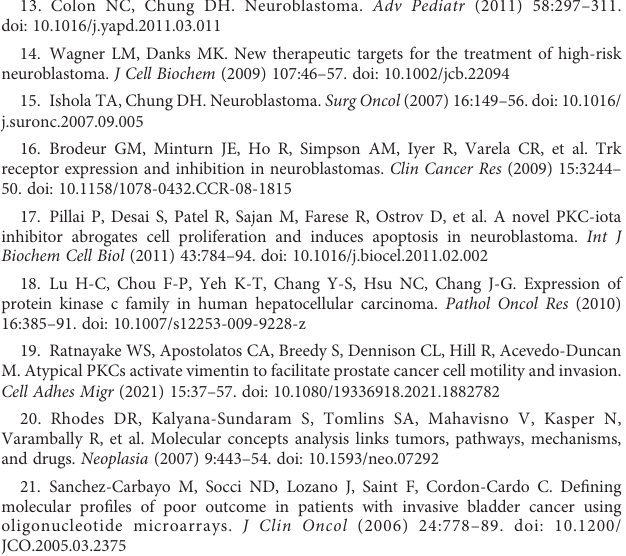
and z -Stat combination on BE(2)-C and (B) the effects of ICA-1S and z -Stat combination on BE(2)-M17. (C) Western blots showing the combinational effects of ICA-1S and z -Stat on aPKC expression and key markers 14-3-3 and Smad 2/3.